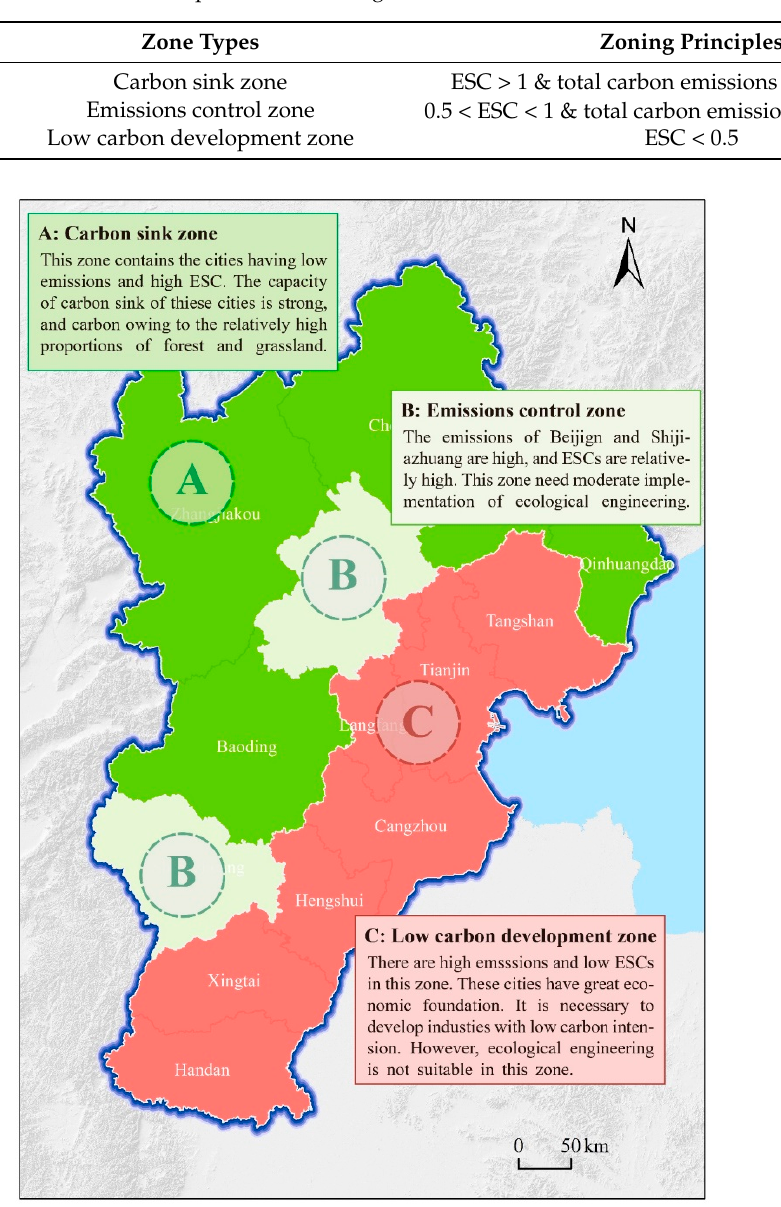
Table 3. Land-use optimization zoning.